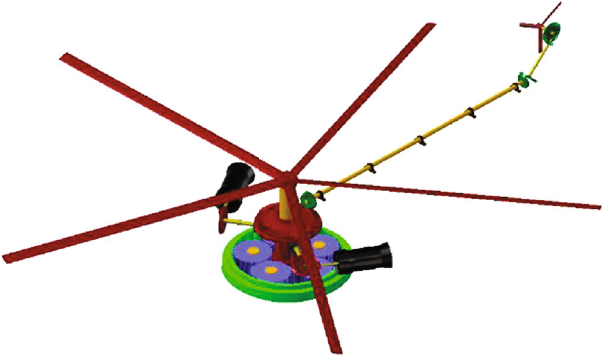
Figure 1: The structure diagram of the study helicopter transmission